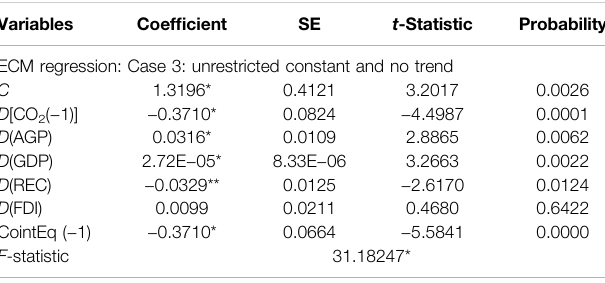
TABLE 5 | Estimated short-run coef fi cients based on Akaike information criterion (AIC).